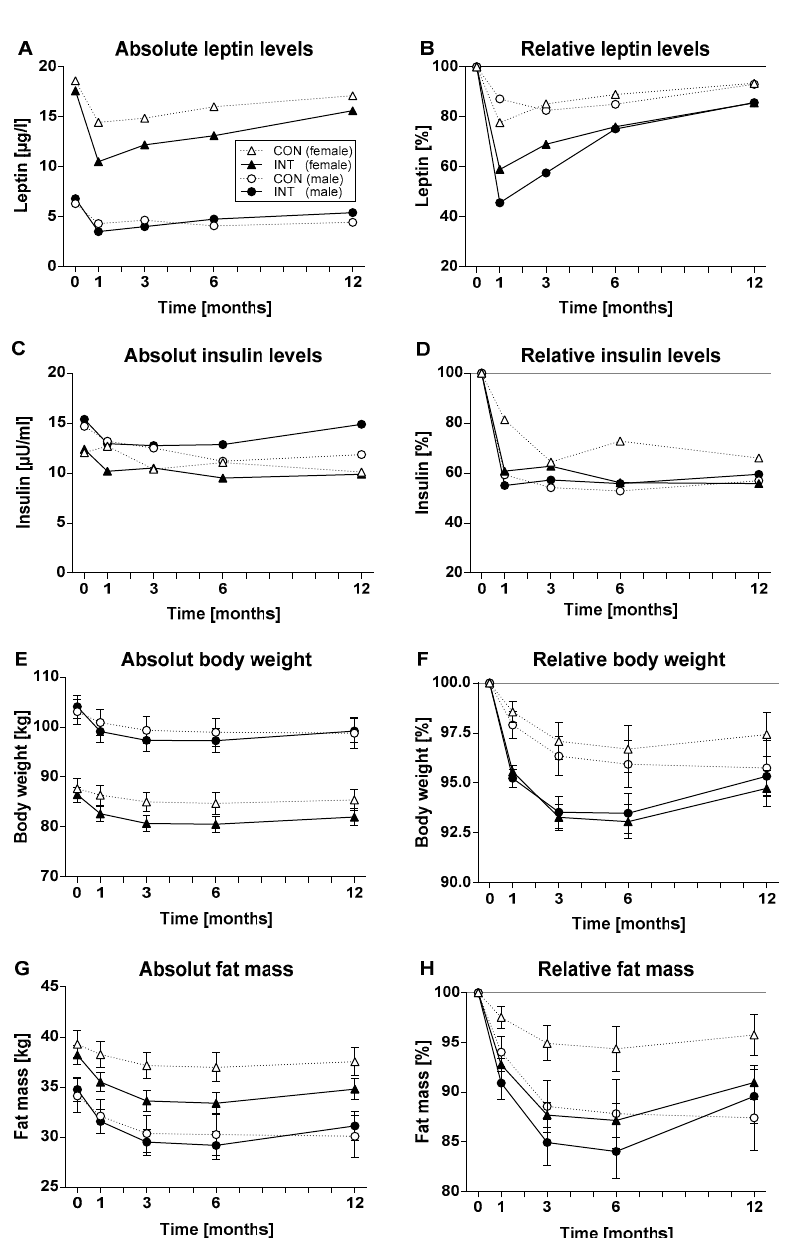
Figure 2. Shown are the courses of ( A ) absolute and ( B ) relative leptin levels in the control (CON) and the intervention (INT) group during the 6-month intervention and 6-month follow up phase separated for female ( Δ CON, n = 80; ▲ INT, n = 195) and male ( ○ CON, n = 54; ● INT, n = 98) participants. ( C ) shows the course of absolute and ( D ) relative insulin levels, ( E ) absolute and ( F ) relative body weight, ( G ) absolute and ( H ) relative fat mass. Leptin and insulin data are shown as median, while body weight and fat mass data are shown as mean [95% confidence interval].